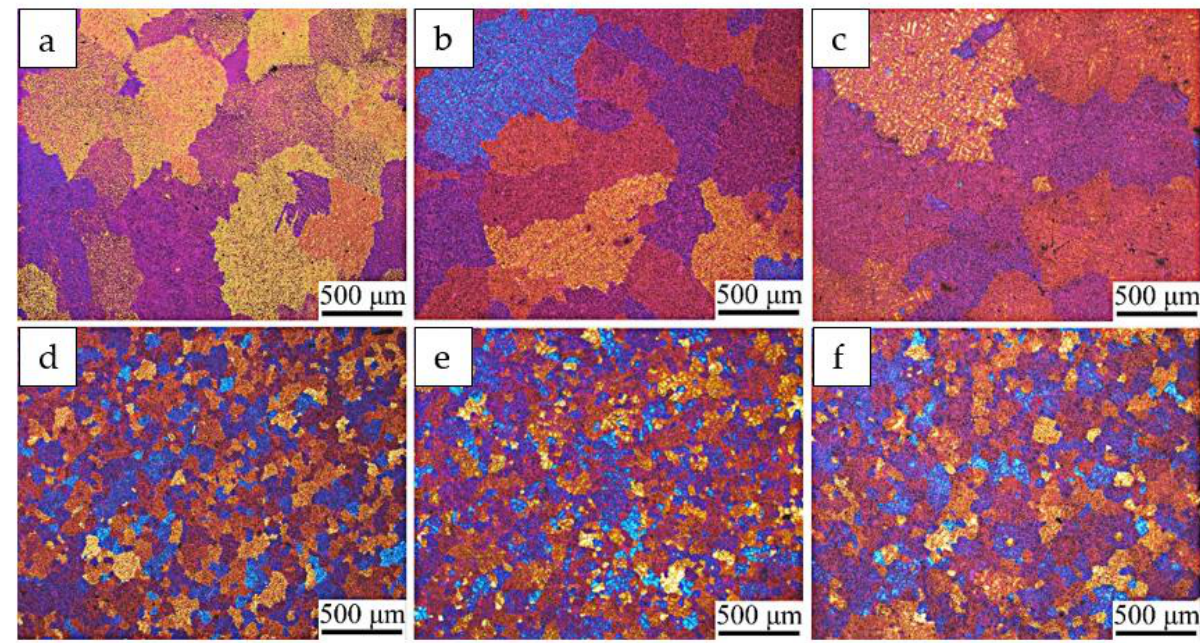
Zn–Mg–Cu alloy billets prepared by NDC casting ( a , b and c ) and UDC casing ( d , e and f ).